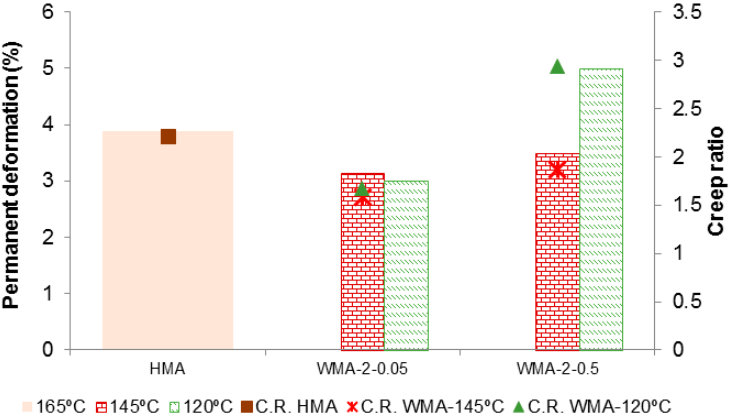
Figure 8. Effect of additive quantity and manufacturing temperature on the resistance to plastic deformations of WMA.